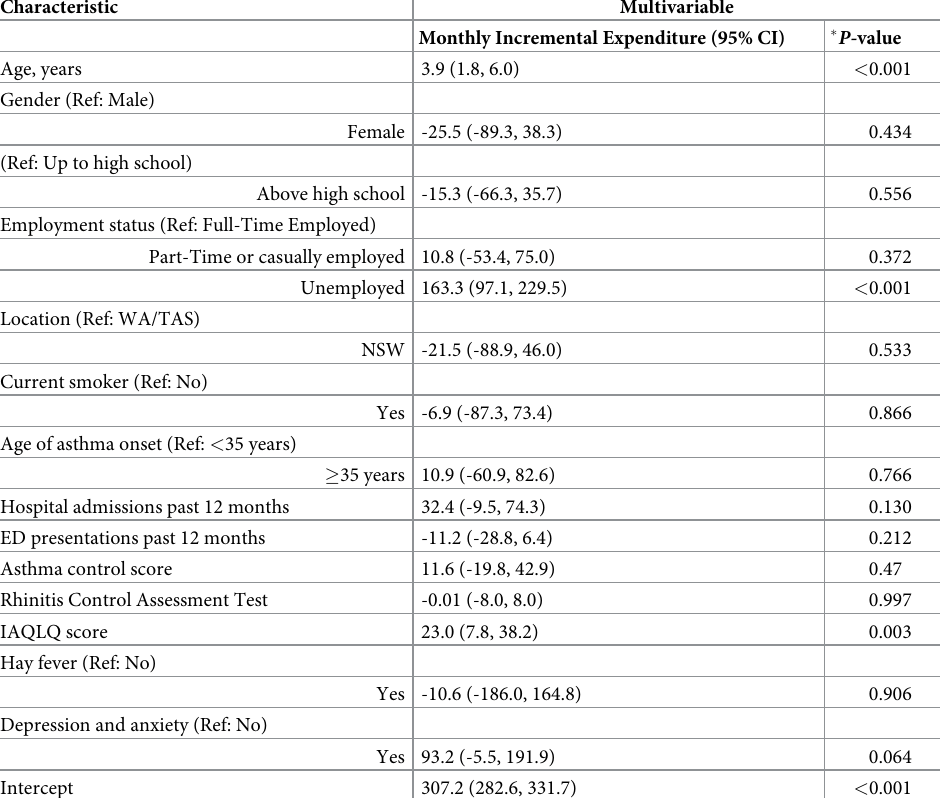
Table 5. Predictors of monthly average total expenditure in participants diagnosed with asthma. Predicted incre- mental costs ($AU) are